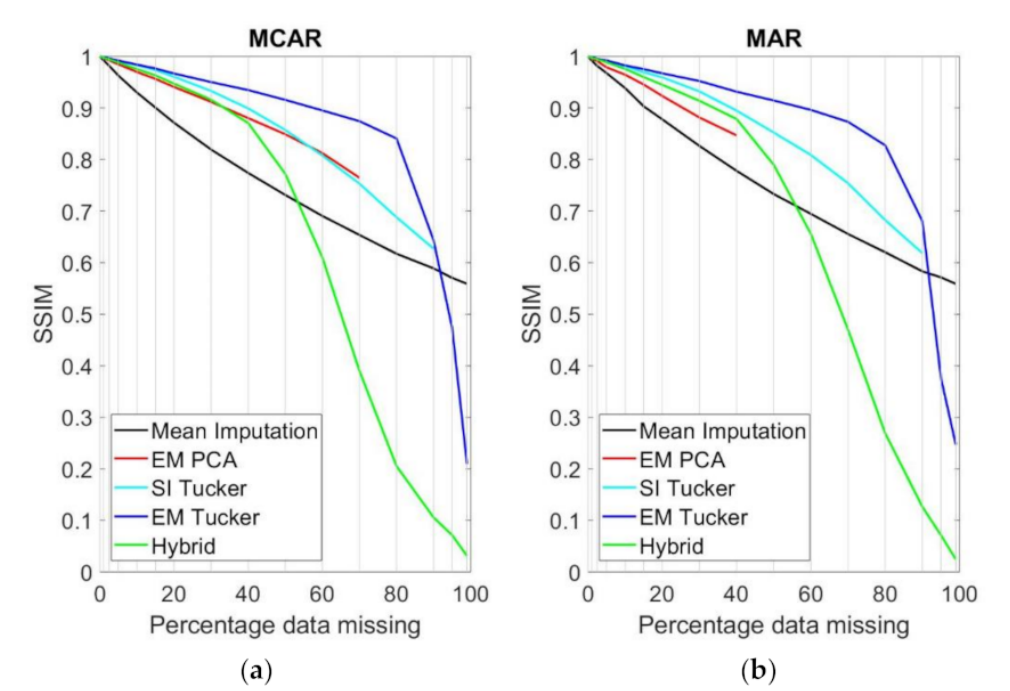
Figure 12. Structural similarity indices (SSIM) for SPAIN1 for all gap-filling methods at different levels of artificially added missing data, both for MCAR ( a ) and MAR ( b